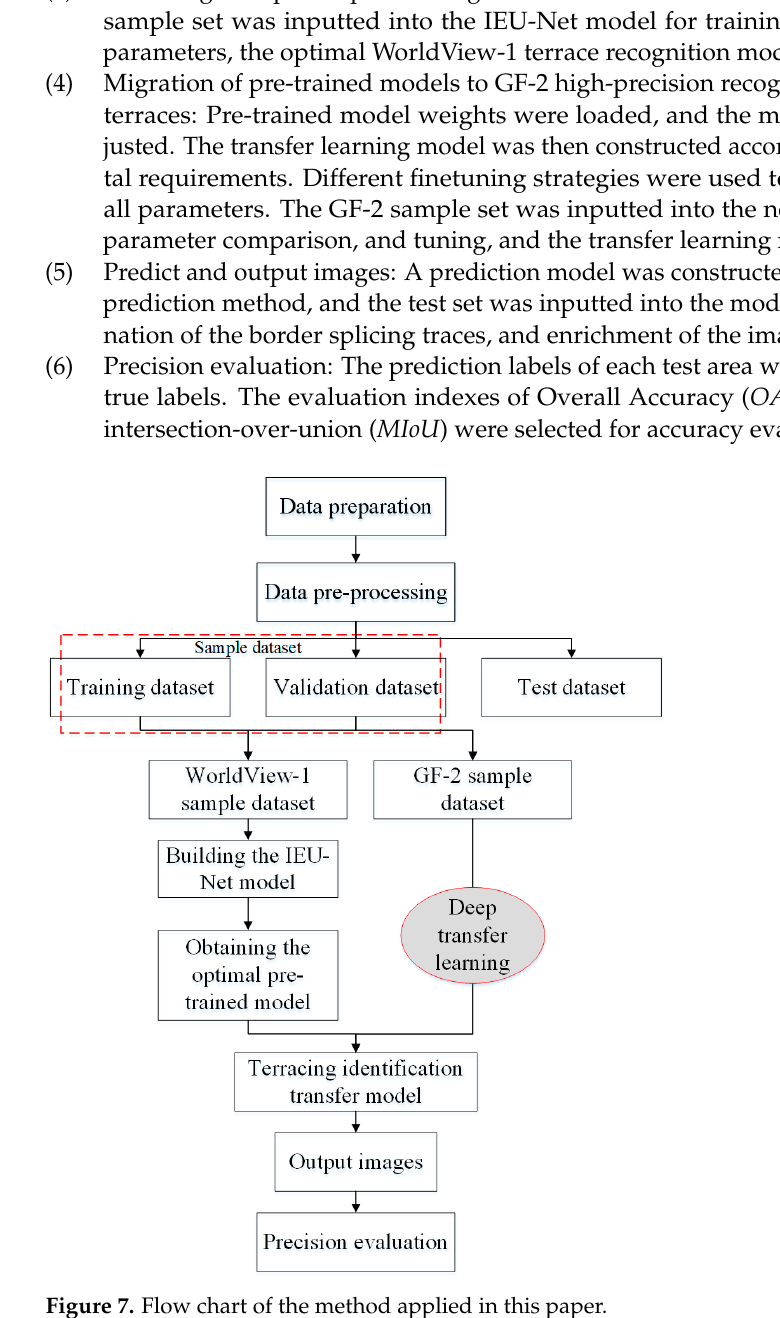
Figure 7. Flow chart of the method applied in this